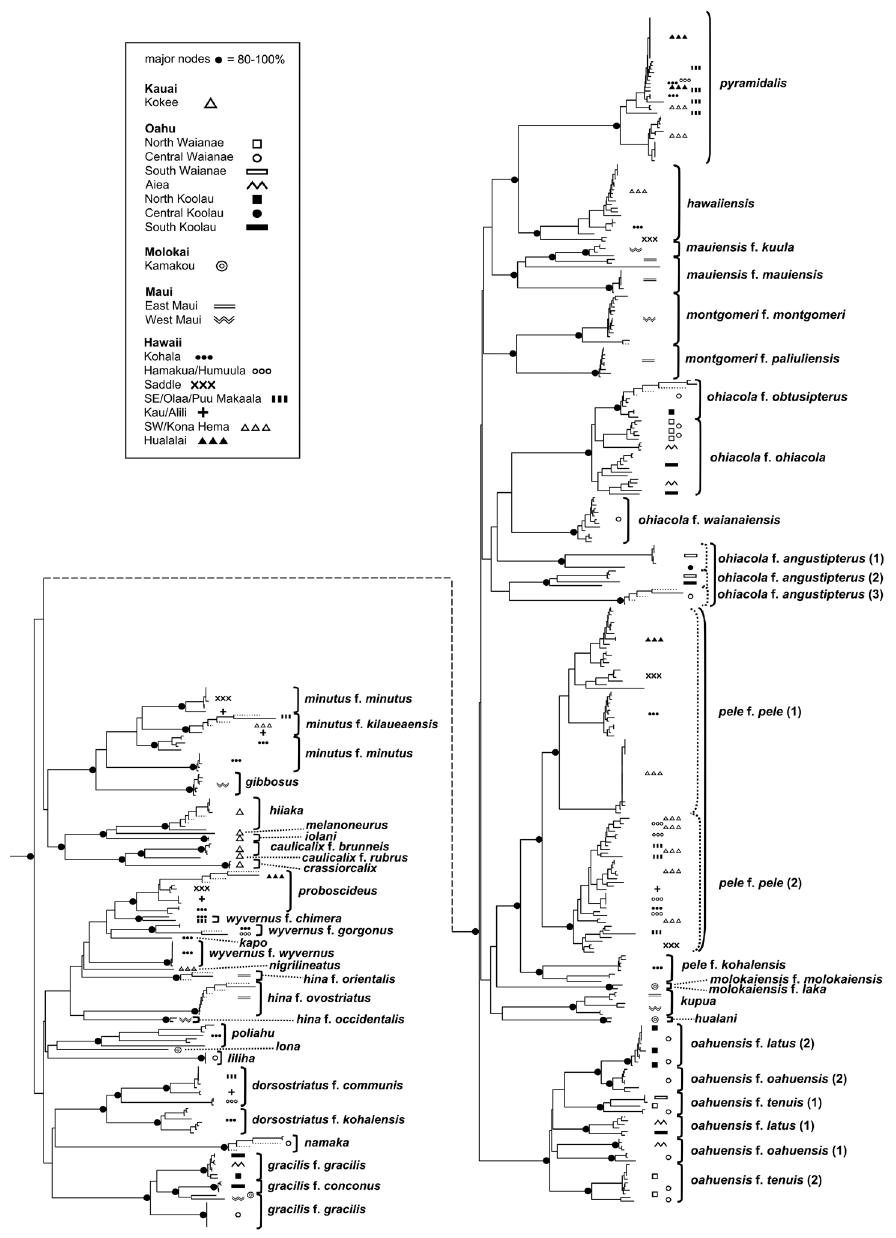
Figure 3. Neighbour-joining analysis (combined COI and cytB data with 1000 bootstrap replicates in PAUP*). The analysis included all 537 sampled individuals, shown here are the 479 individuals within Pariaconus . Described species and recognized forms are indicated as well genotypic clusters within forms. Regional locations for sampling sites within islands are shown to give an idea of geographic clustering and isolation (e.g. P. pele form pele cluster 1 has regionally distinct clusters, whereas P. pele form pele cluster 2 is composed of regionally mixed clusters). Support (80-100%) is indicated for major nodes